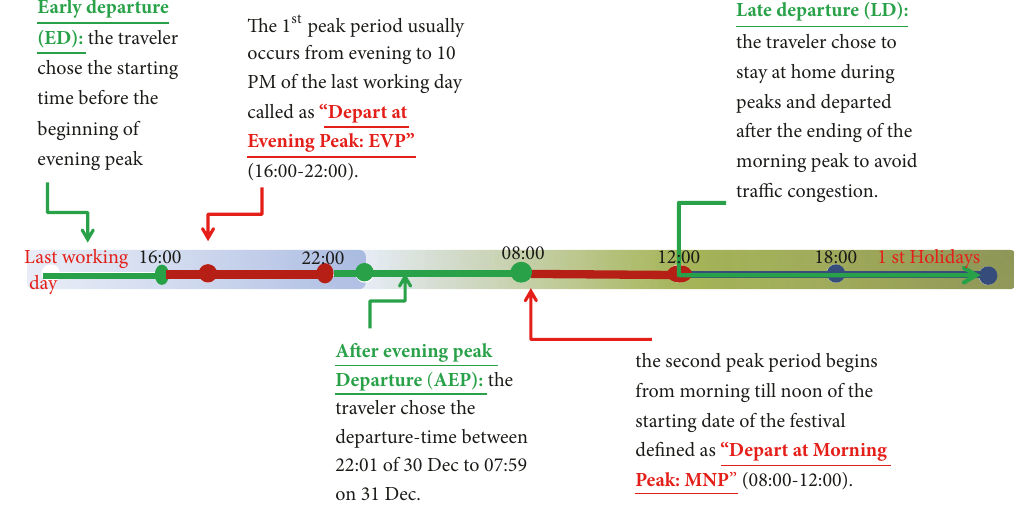
Figure 2: Definition of five alternatives of departure